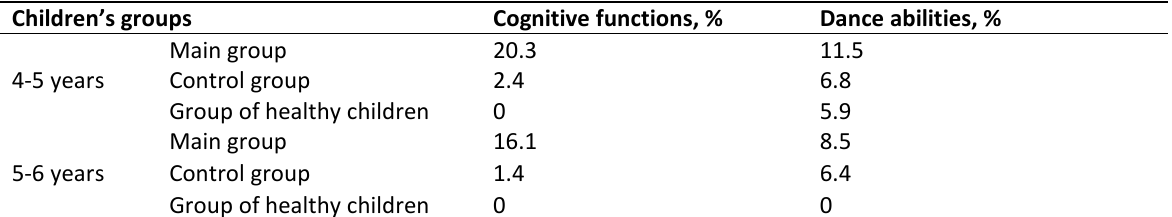
Table 2. Results of confident cognitive functions’ and dance abilities’ changes in 4-6 years’ age children at the end of academic year Children’s groups Cognitive functions, % Dance abilities,